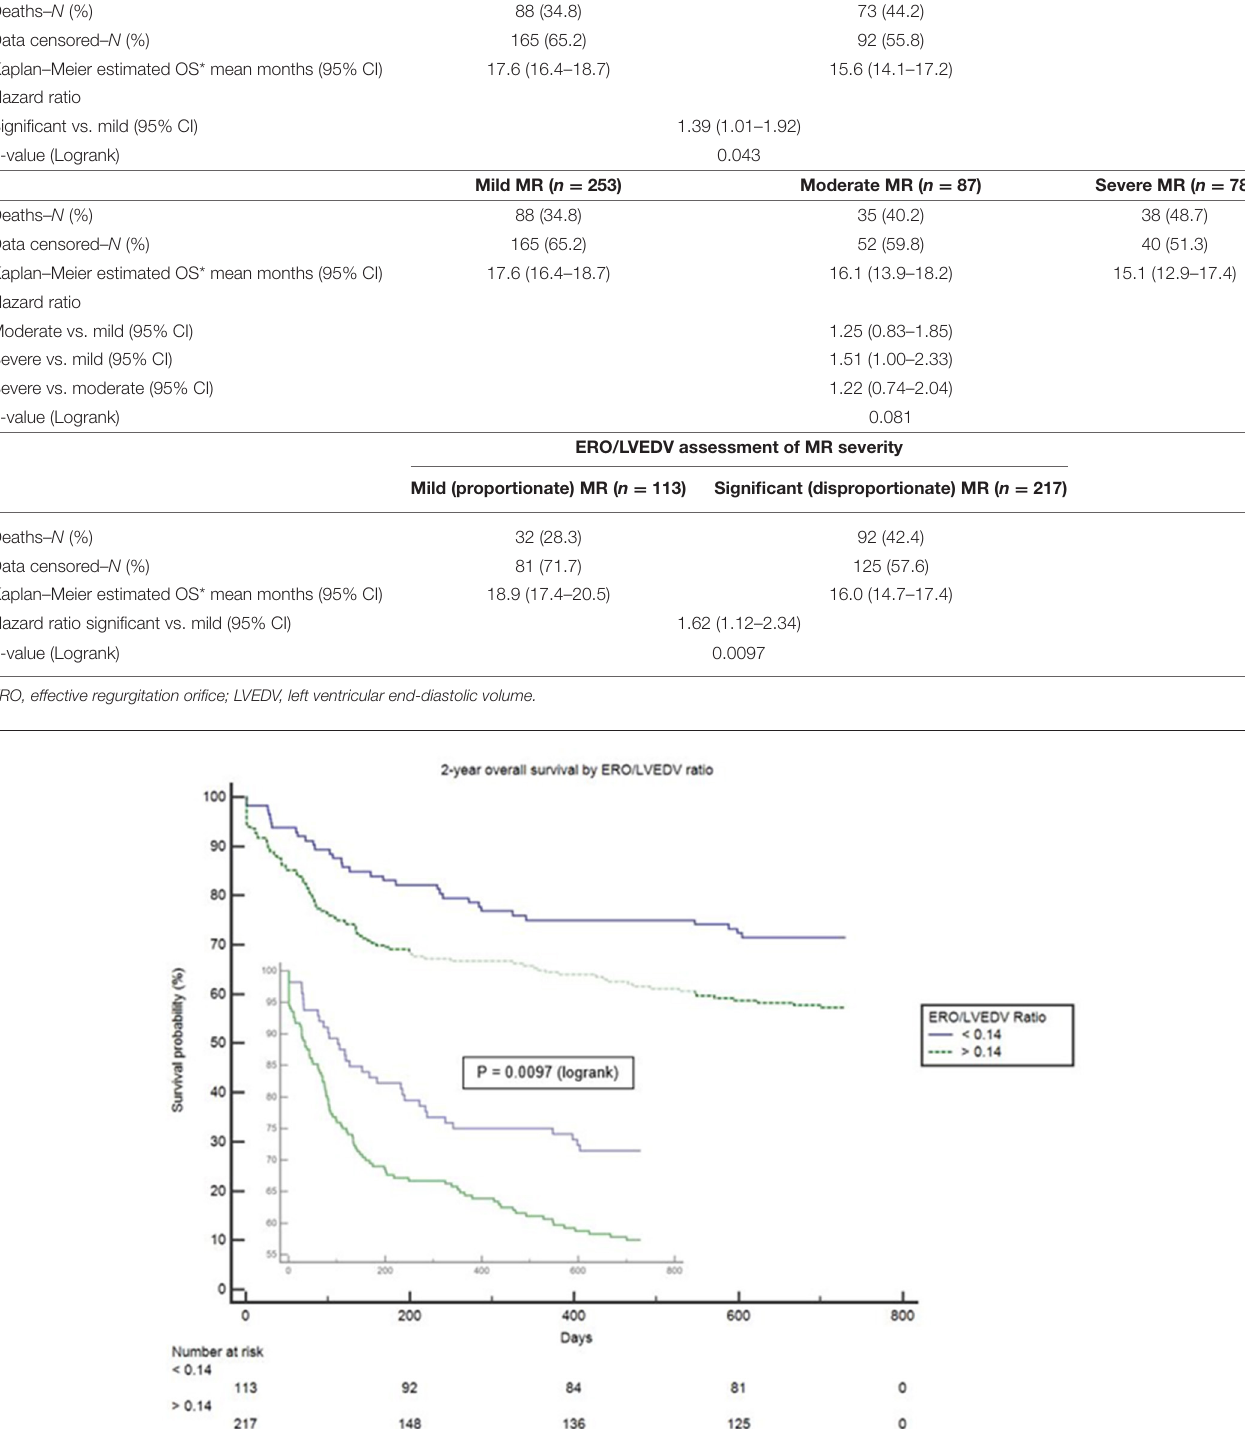
Frontiers in Cardiovascular Medicine |